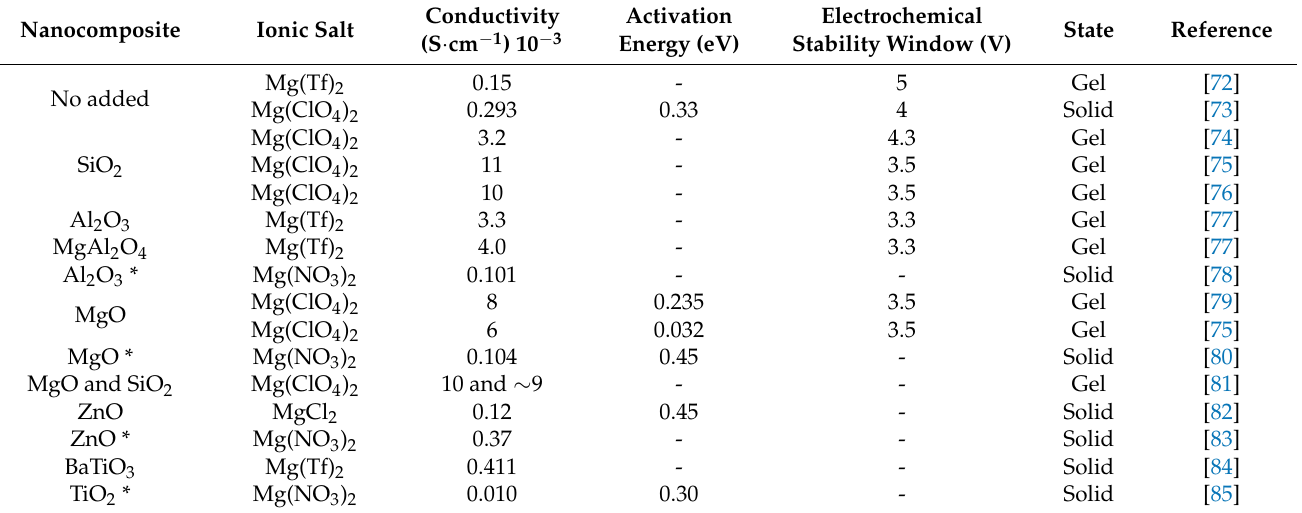
* PVDF without copolymerization with